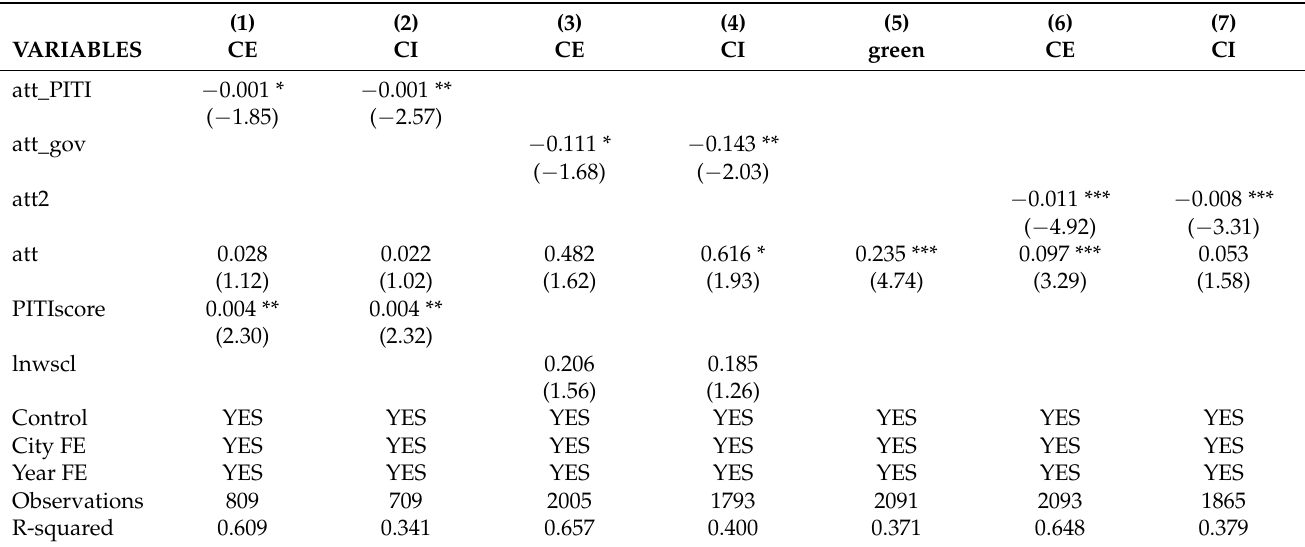
Table 15. Interaction with government and ENGOs, mechanism analysis and nonlinear